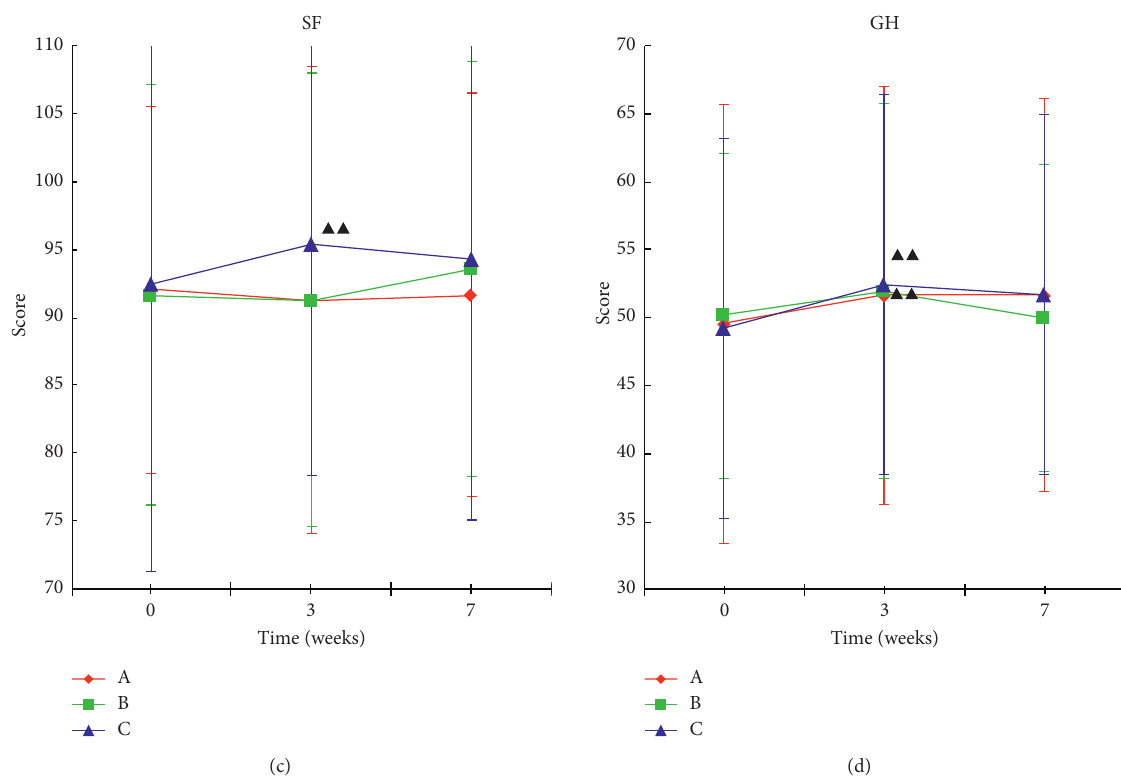
Figure 7: Comparison of the scores of the four health survey dimensions of each group of patients. Data were expressed as mean ± s ( n � 33). ΔΔ P < 0 . 01, compared to baseline.